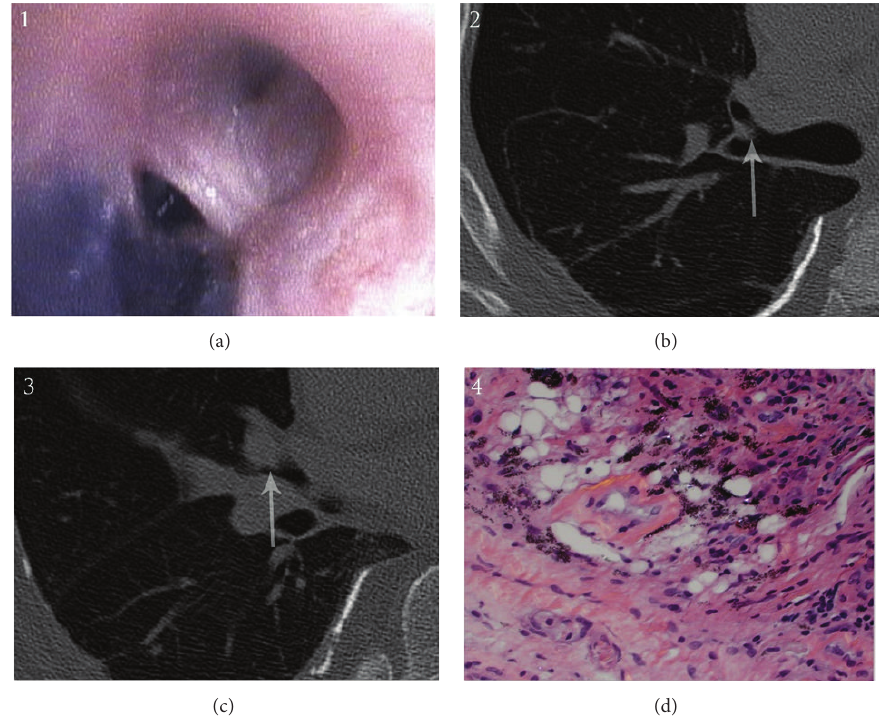
Figure 1: A bronchoscopy photograph of a pigmented anthracotic nodule partially obstructing the right upper lobe anterior segment takeoff (a). This is visible on a CT scan of the area (b, arrow). Similar changes are seen in the right middle lobe (c). Microscopic evaluation under polarized light (400x H&E stain) shows birefringent material along with the anthracotic pigment in a background of mild chronic inflammation